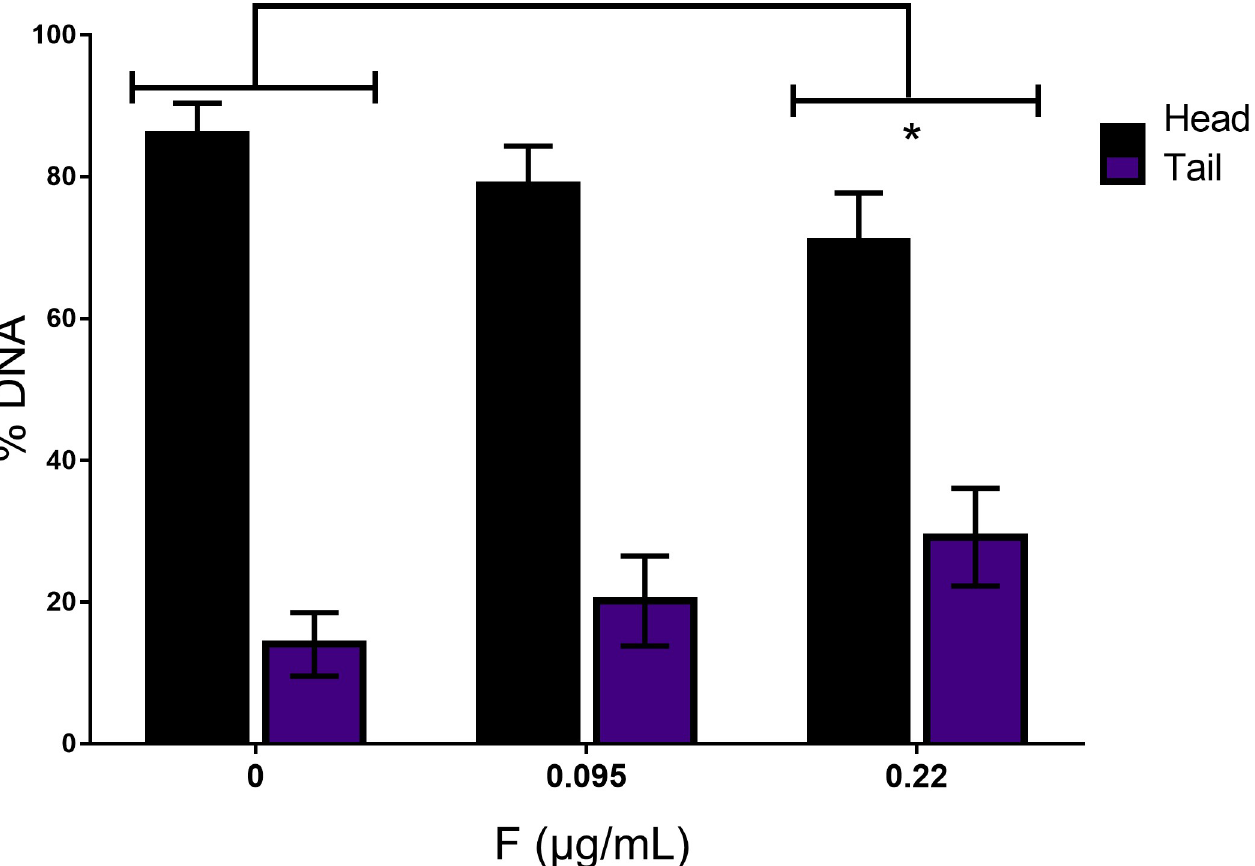
Fig 7. DNA fragmentation of U87 glial cells after 10 days of 0.095 and 0.22 μ g/mL F exposure was analyzed by comet assay. Data were showed as % of DNA on head and tail and expressed as mean ± SD. Statistical analysis were performed by one-way ANOVA followed by Tukey. Statistical significance compared to control group was showed by � whenever p <